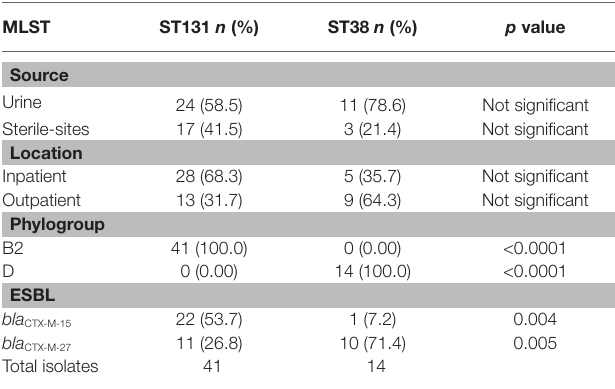
TABLE 1 | Distinguishing features of ST131 and ST38 isolates sequenced in this